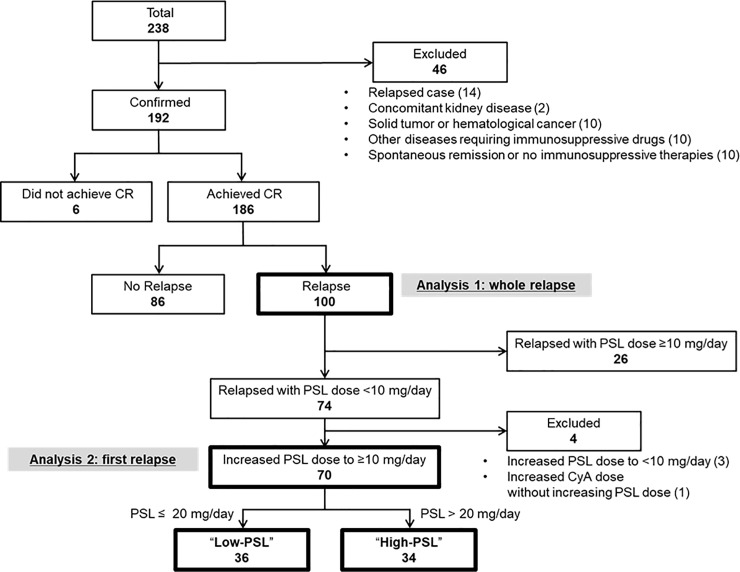
Overview of this study.Of the 238 adult patients with minimal change disease in the cohort, 192 were eligible for this study. Analysis 1: For the 100 identified patients with relapse, treatment regimens at every relapse were reviewed. Analysis 2: To evaluate the association between steroid dose and subsequent outcomes, patients who fulfilled the criteria as indicated in the flow chart were divided into two groups: “High-PSL” and “Low-PSL.” Abbreviations: CR; complete remission, PSL; prednisolone; CyA, cyclosporine A.